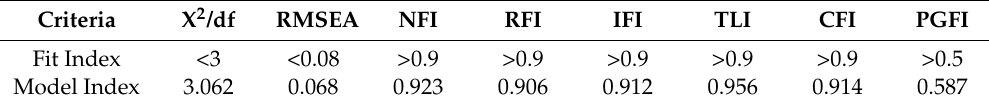
Table 5. Model fitting criteria and results.